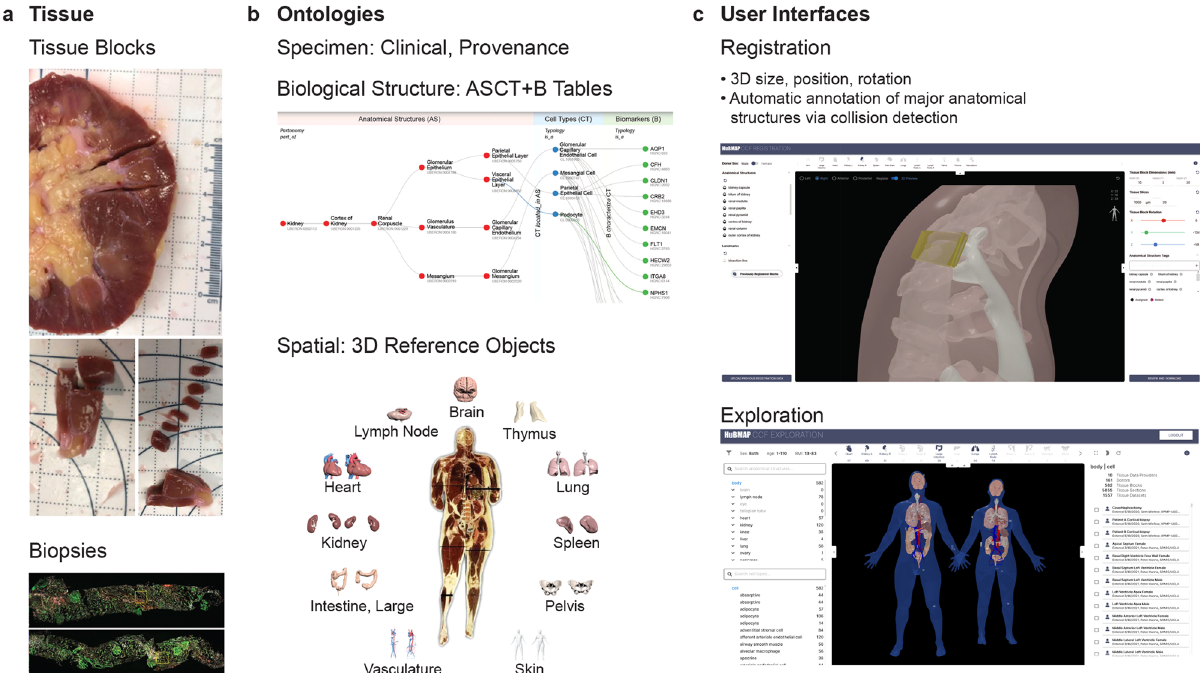
Fig. 3 Work fl ow. a Tissue data (blocks or biopsies) are secured by different laboratories/projects from different donors and organs. b Three different ontologies capture specimen, biological structure, and spatial metadata derived from organ-speci fi c ASCT + B tables and 3D reference objects. c The RUI (top) is used to register tissue data while the EUI (bottom) supports ontologically and spatially explicit exploration of tissue and HRA data across organs, donors, laboratories, and